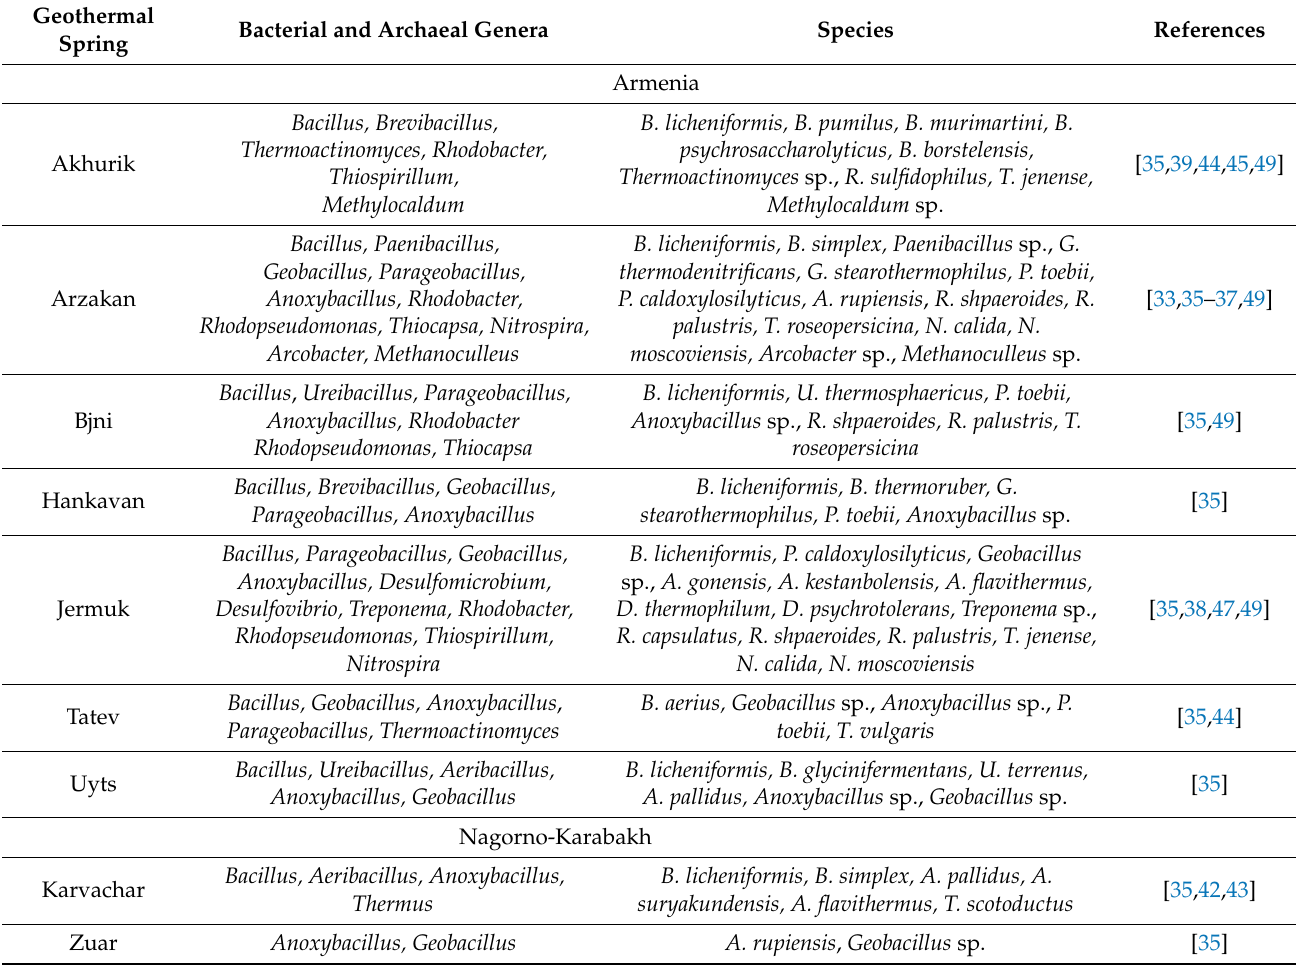
Table 2. Summary of the thermophilic bacteria isolated from Armenian geothermal springs.